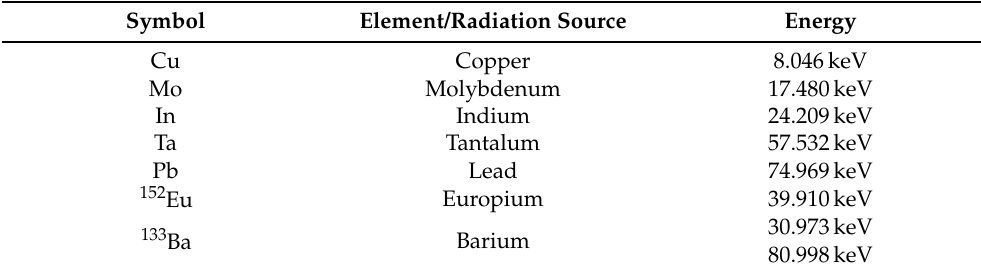
Table 1. List of radiation sources and target materials with their characteristic